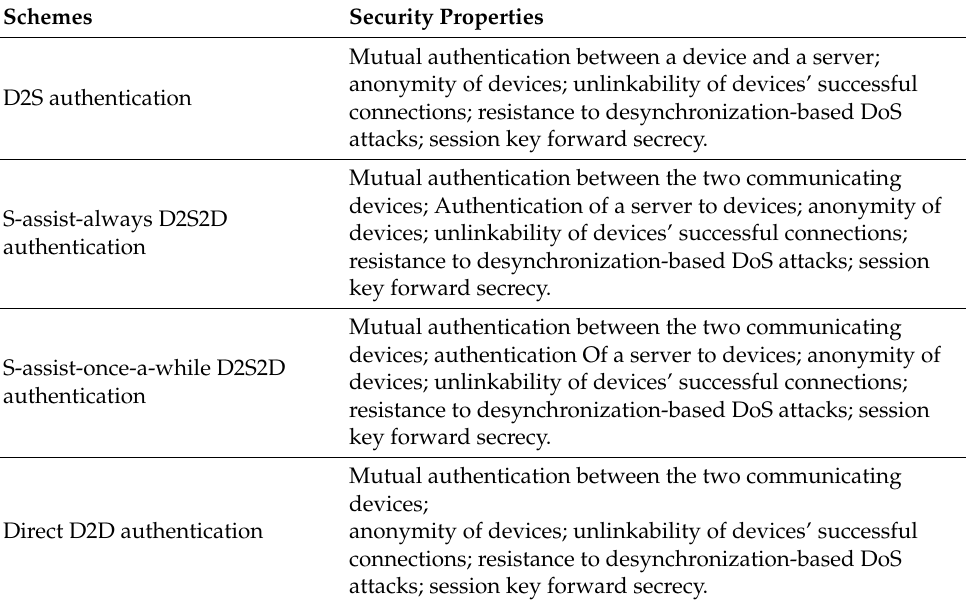
Table 2. Summary of the security